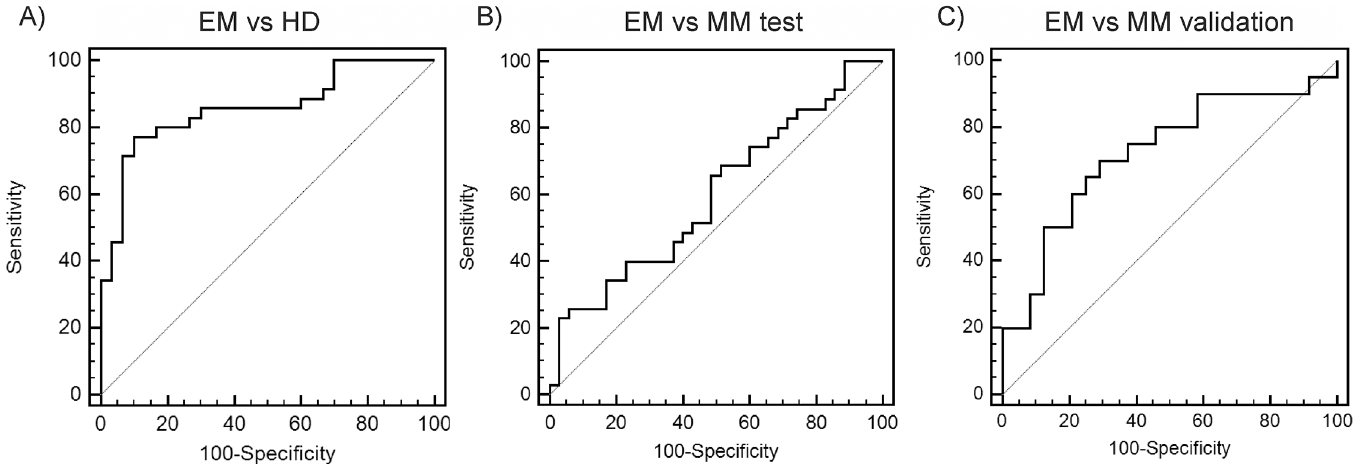
Fig 2. Receiver operating characteristic (ROC) analysis. ROC curves for miR-130a distinguishing A) extramedullary myeloma (EM) patients from healthy donors (HD) with area under the curve (AUC) = 0.856, B) EM patients from newly diagnosed multiple myeloma patients (MM new diagnosis) with AUC = 0.598 in a test cohort C) EM patients from MM patients (with PET/CT negative for EM) with AUC = 0.761 in a validation